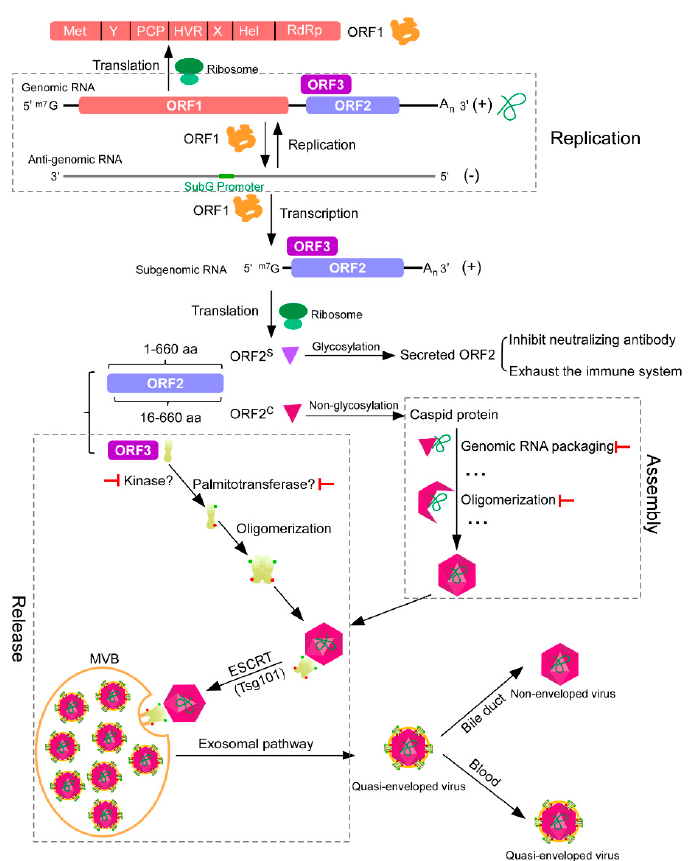
Figure 1. Schematic representation of hepatitis E virus (HEV) replication, assembly, and release. After HEV enters the cell, the ORF1 is translated by the host ribosome. The ORF1 can replicate HEV genomic RNAs and transcribe subgenomic RNAs. Subgenomic RNAs encode both ORF2 and ORF3. ORF2 is a capsid protein, which has two forms, secreted and capsid, translated from different start codons. Secreted ORF2 can function as a decoy to inhibit the neutralizing antibody or to exhaust the immune system. Capsid ORF2 can bind genomic RNA and oligomerize to form viral particles. ORF3, which can be phosphorylated and palmitoylated to form oligomer, is required for viral particle release from host cells, functioning as an ion channel. ORF3 can interact with both ORF2 and tumor susceptibility gene 101 (Tsg101), a component of the cellular endosomal sorting complexes required bodies (MVBs) through the exosomal pathway, which then fuse with the plasma membrane to release